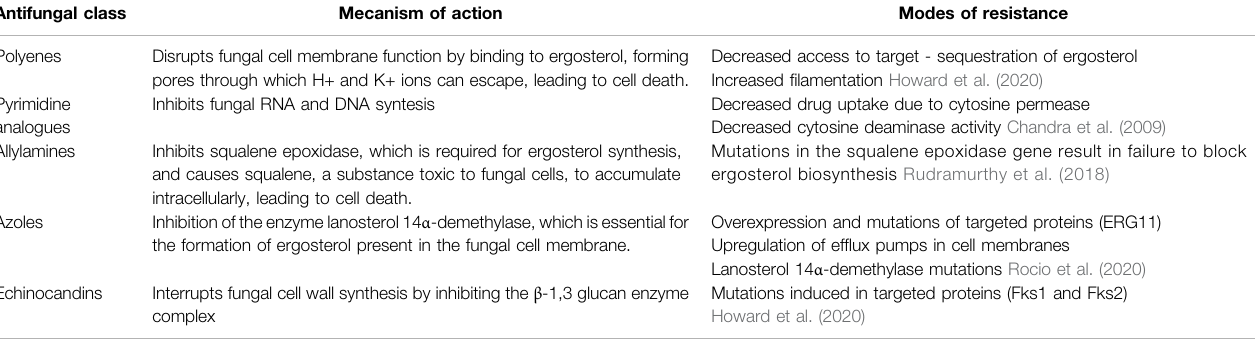
TABLE 4 | Mechanism of action of currently used antifungal agents and modes of resistance.